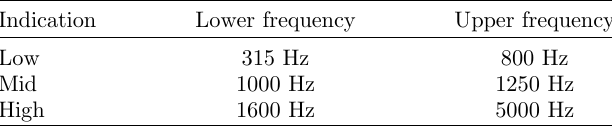
Table 1. Center frequencies of the CPX one-third octave band limits for the three model frequency